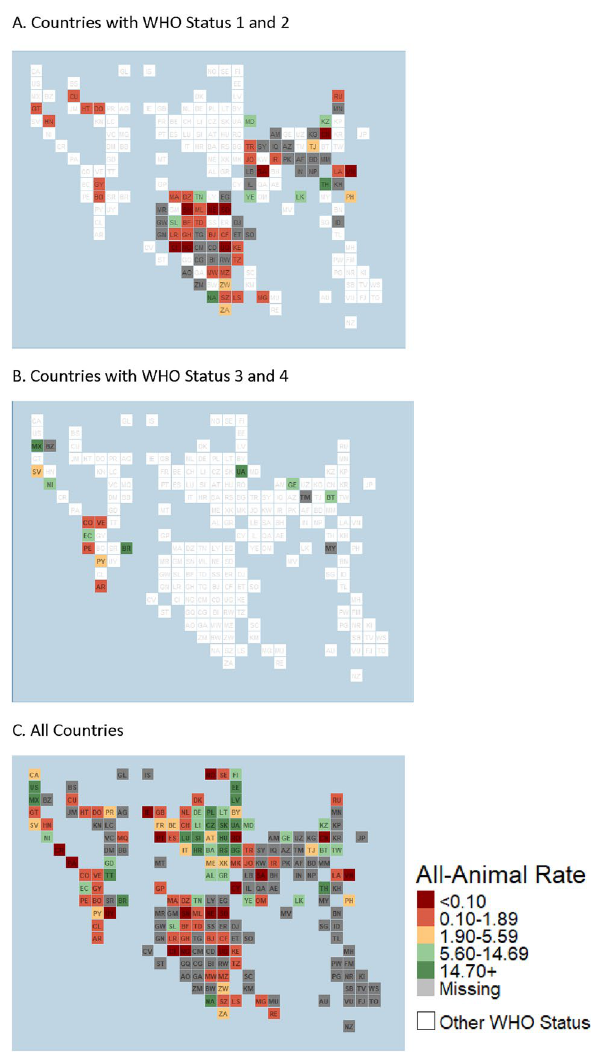
Figure 2. All-animal Testing Rate/100,000 Human Population. Countries are represented by their official two letter ISO 3166 alpha-2 (https:// www. iban. com/ count ry- codes), in equal tiles such that countries could be represented equally without over or underrepresentation based on geographic area, and by WHO Rabies Statuses: ( A ) represents Status 1 and 2 only, ( B ) represents Status 3 and 4 only, and ( C ) represents all